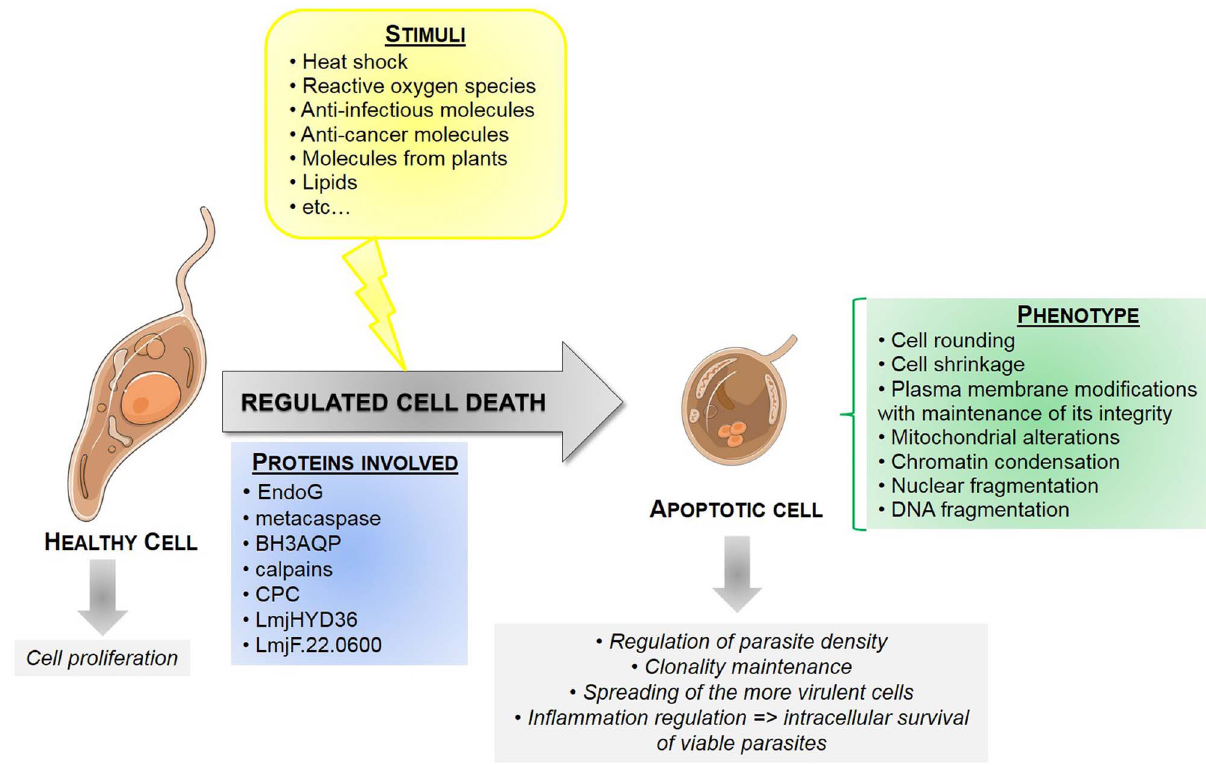
Figure 5. Schematic representation of L. major RCD. This schematization summarizes the physiological roles of Leishmania RCD, the phenotype of apoptosis, the pro-apoptotic stimuli and the proteins involved that are currently